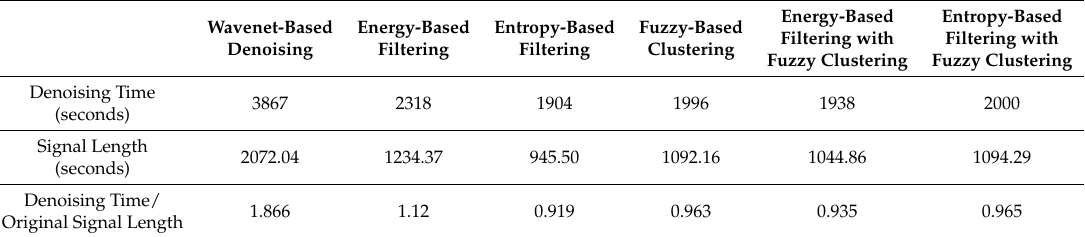
Table 3. The execution time and length comparison between the proposed method and Wavenet-based